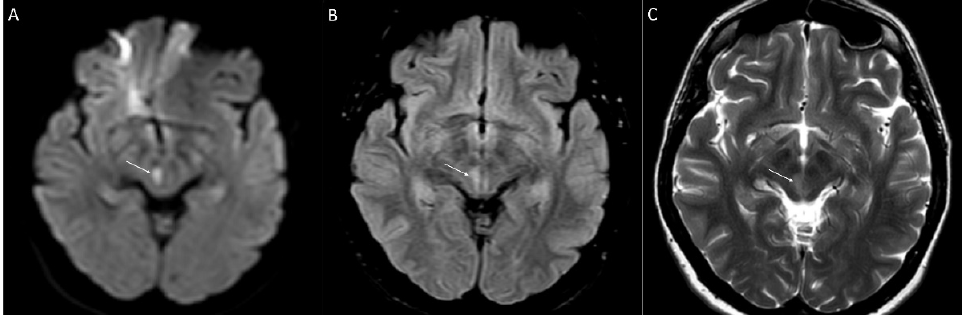
Figure 2. Axial MRI illustrates a lacunar infarct in the left midbrain of the patient 2.0 (white ar- rows) on day 3 post-stroke ( A – C ). ( A ) Diffusion-weighted imaging shows hypersignal lesion in midbrain (restricted diffusion). ( B) Fluid-attenuated inversion recovery demonstrates hypersignal lesion. ( C ) T2-weighted imaging shows hypersignal lesion.